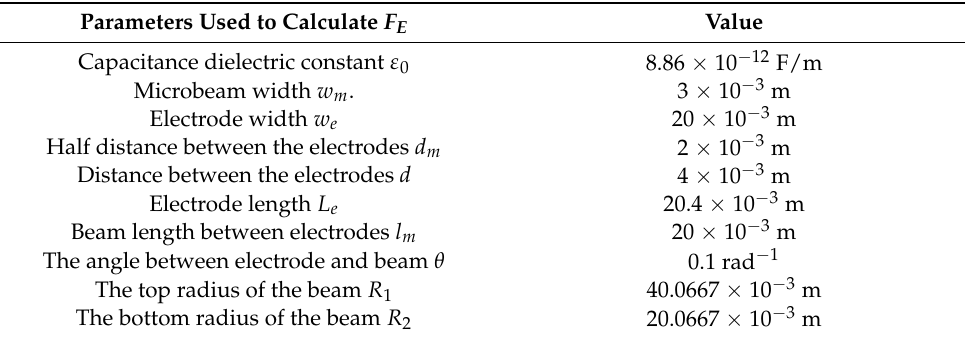
Table A1. Parameter values of the simulation model.